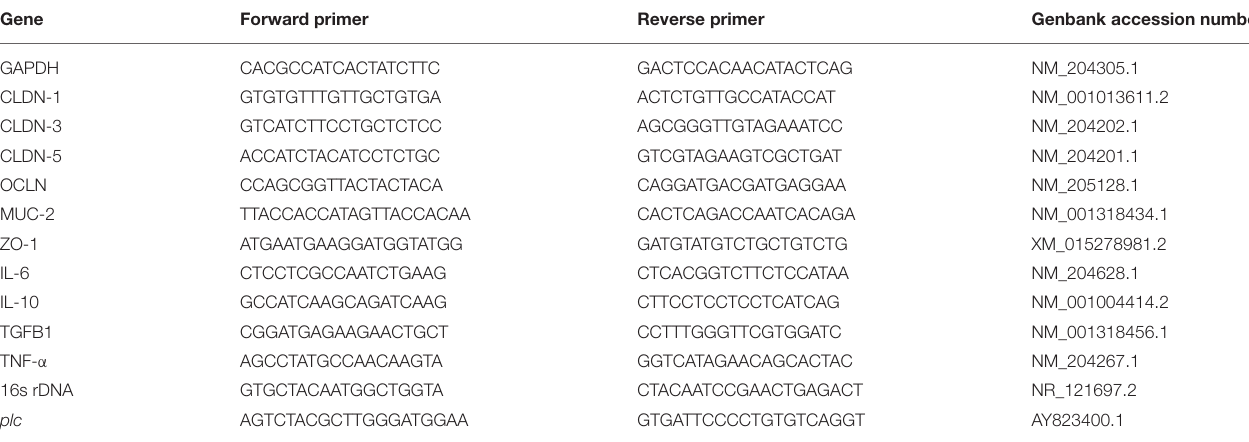
TABLE 3 | Quantitative real-time PCR primer sequences.